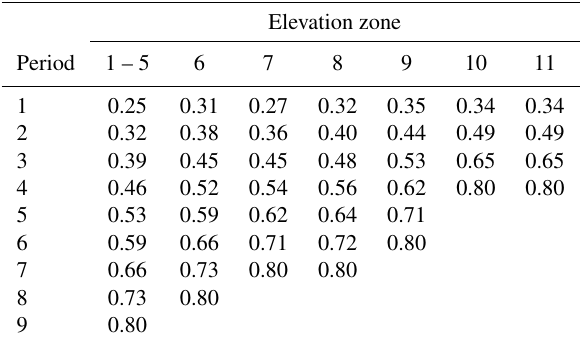
Table 1. Zone-wise degree-day factors depending on 10-days peri- ods after melting